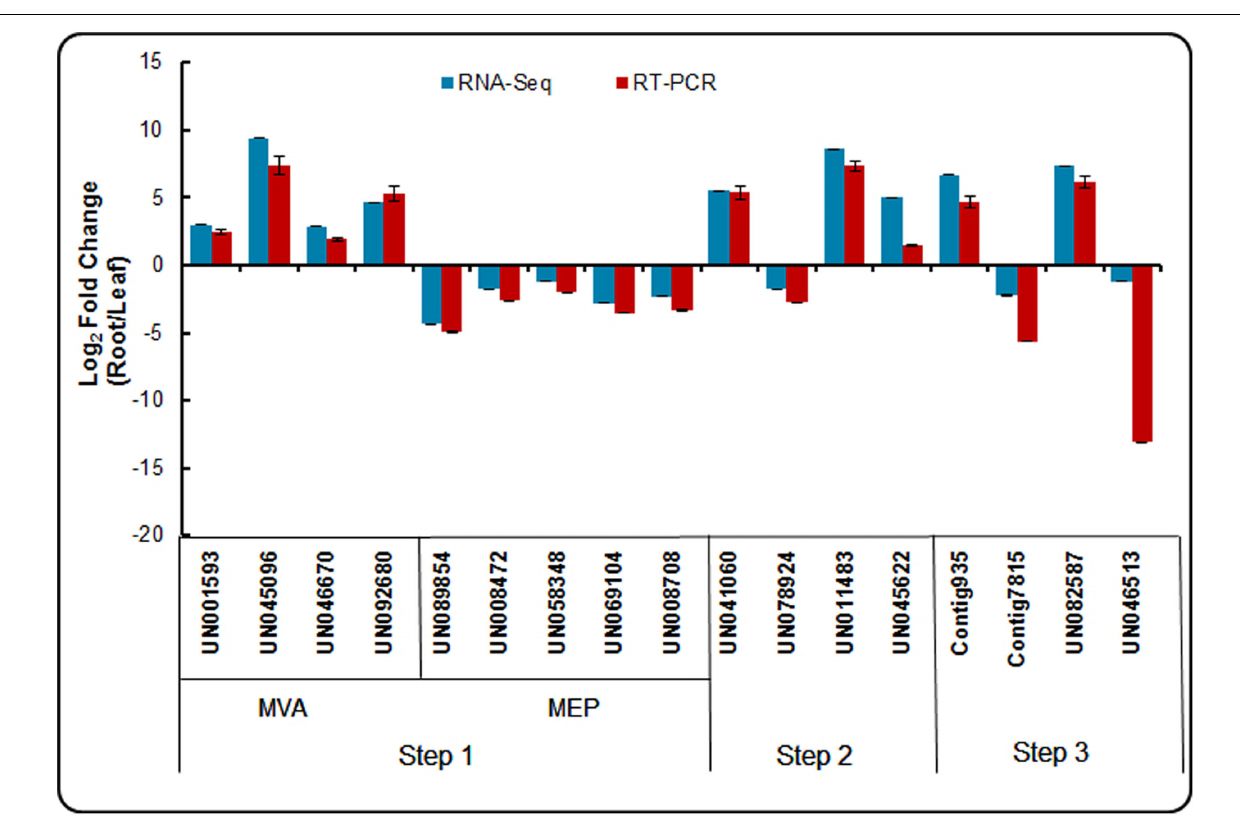
FIGURE 9 | Expression patterns of genes involved in triterpenoid saponion and sterol biosynthesis pathway detected by RNA-seq and